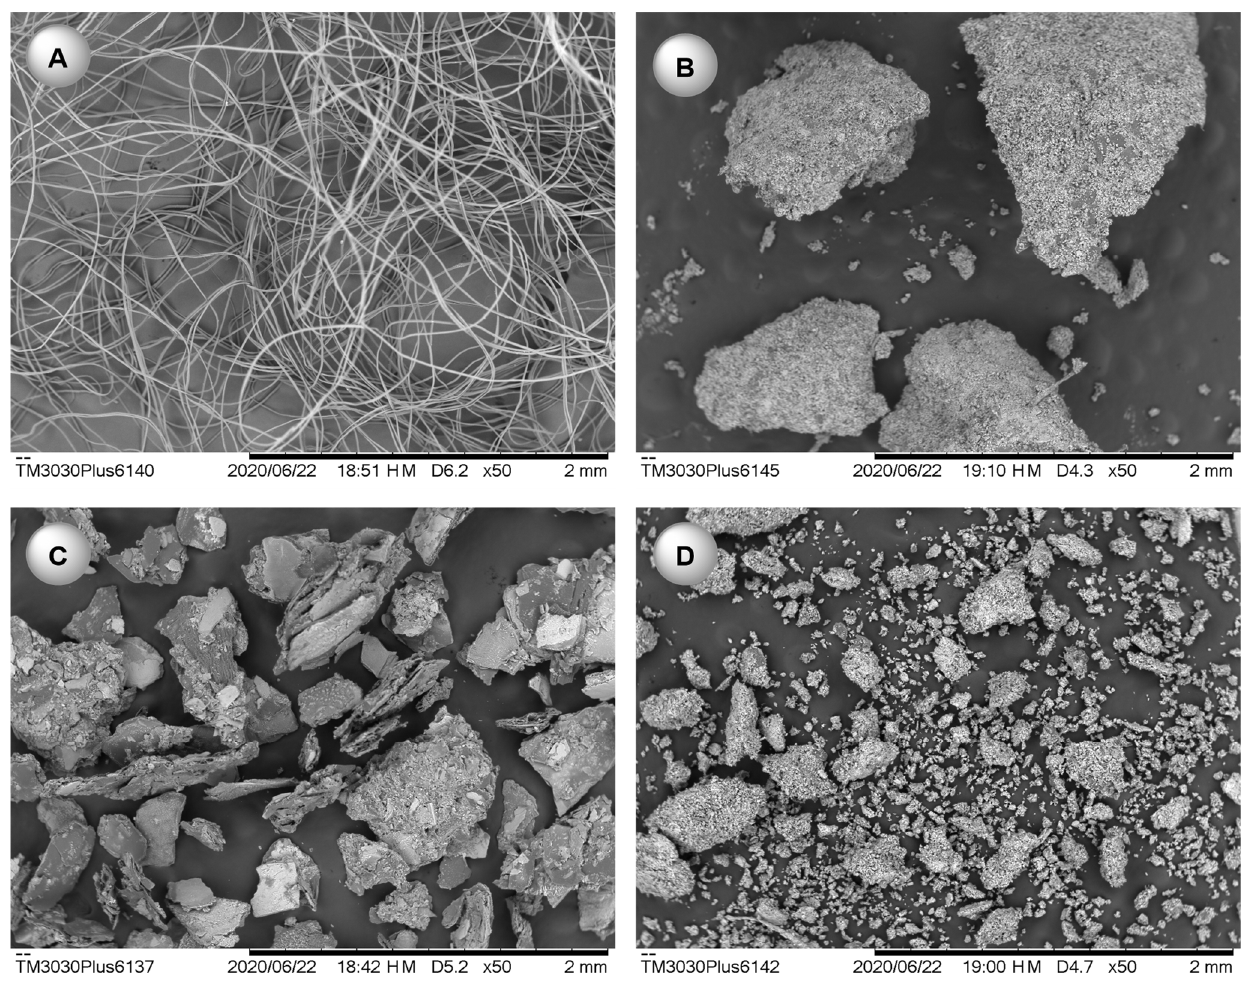
Figure 3. Scanning electron microscopy images of silk-fibroin ( A ), silk-fibroin-Oxone ® ( B ), chitin ( C ), and chitin-Oxone ® ( D ).